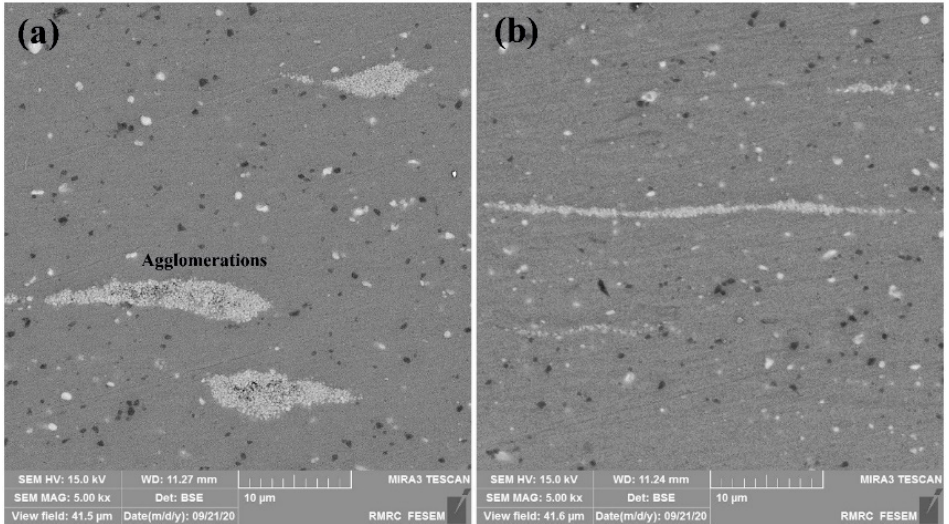
Figure 4. Mechanical properties of Al/TiC composites. Figure 5. The SEM microphotographs of a stir casted Al/TiC composite for samples ( a ) as stir casted and ( b ) after eight steps of APB.